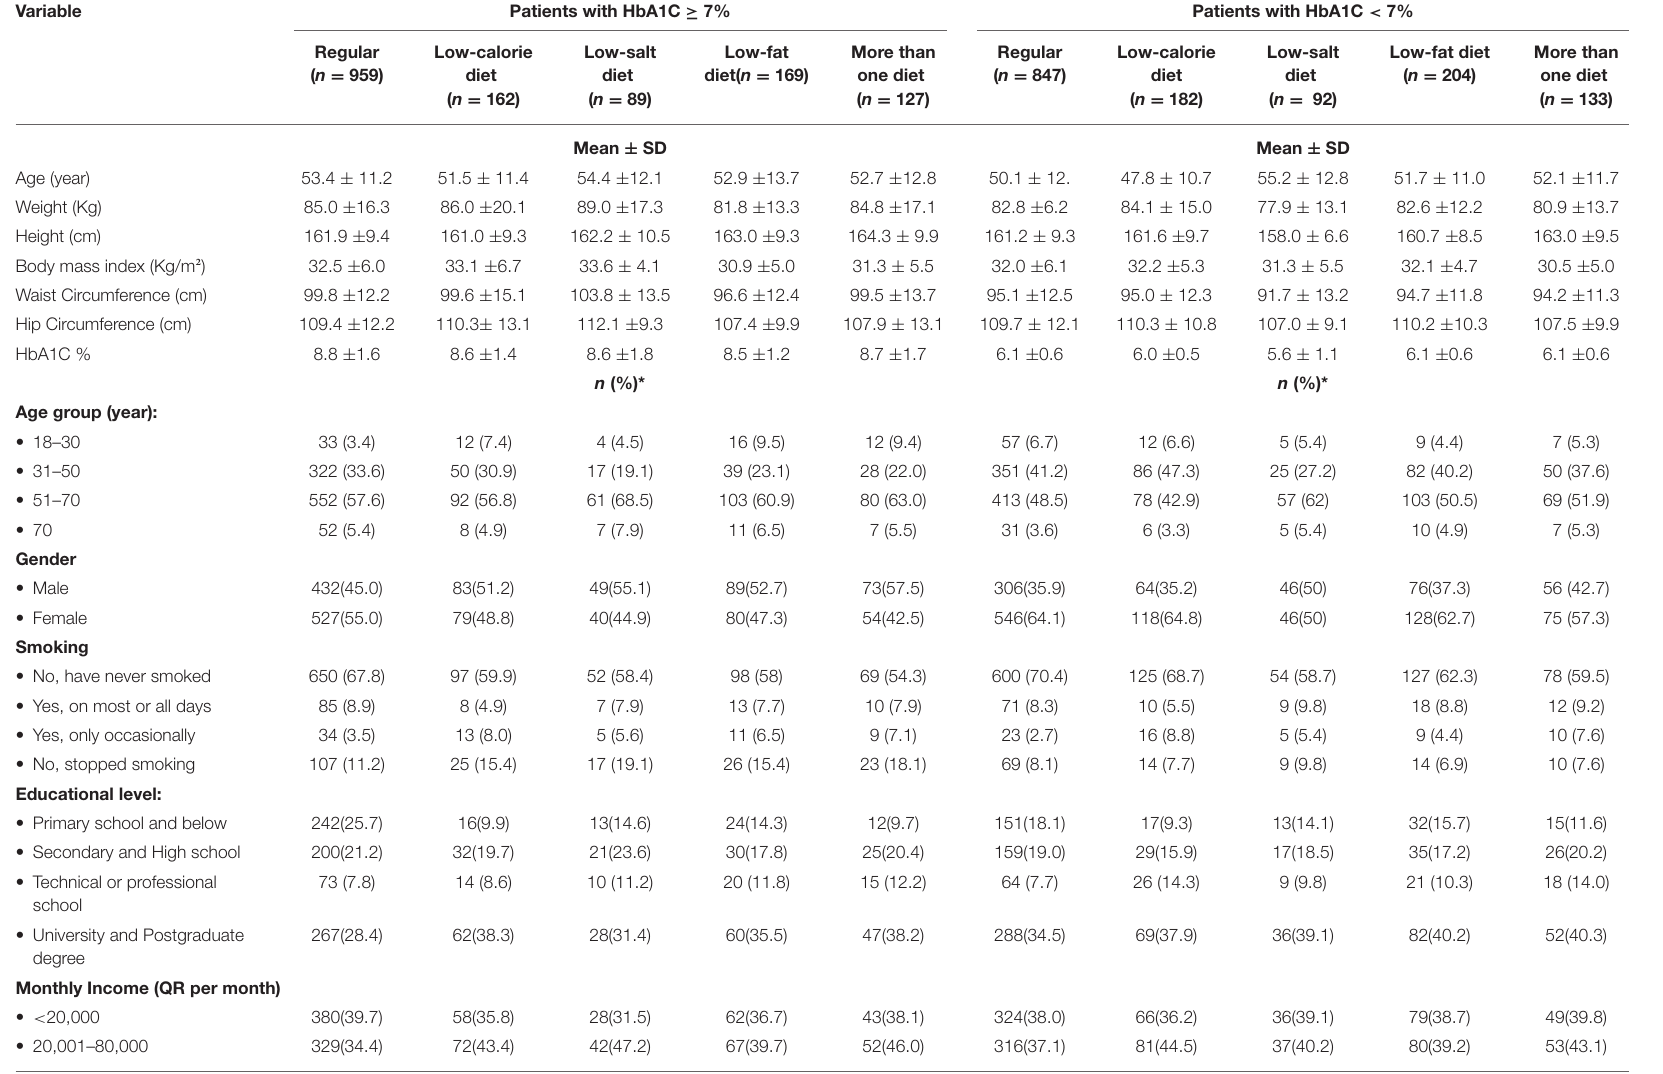
TABLE 1 | Characteristics of the study sample by diet type. Variable Patients with HbA1C ≥ 7% Patients with HbA1C <